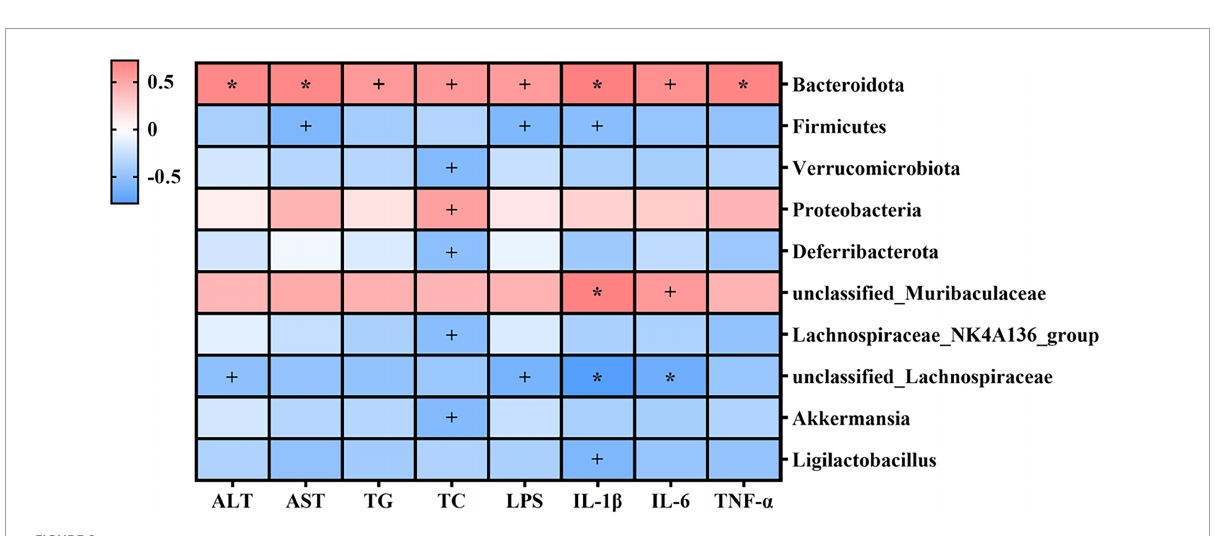
changes in ALD (27). In this study, the liver tissues of the MOD group showed obvious aggregation of lipid droplets and inflammatory cell infiltration through the histopathological